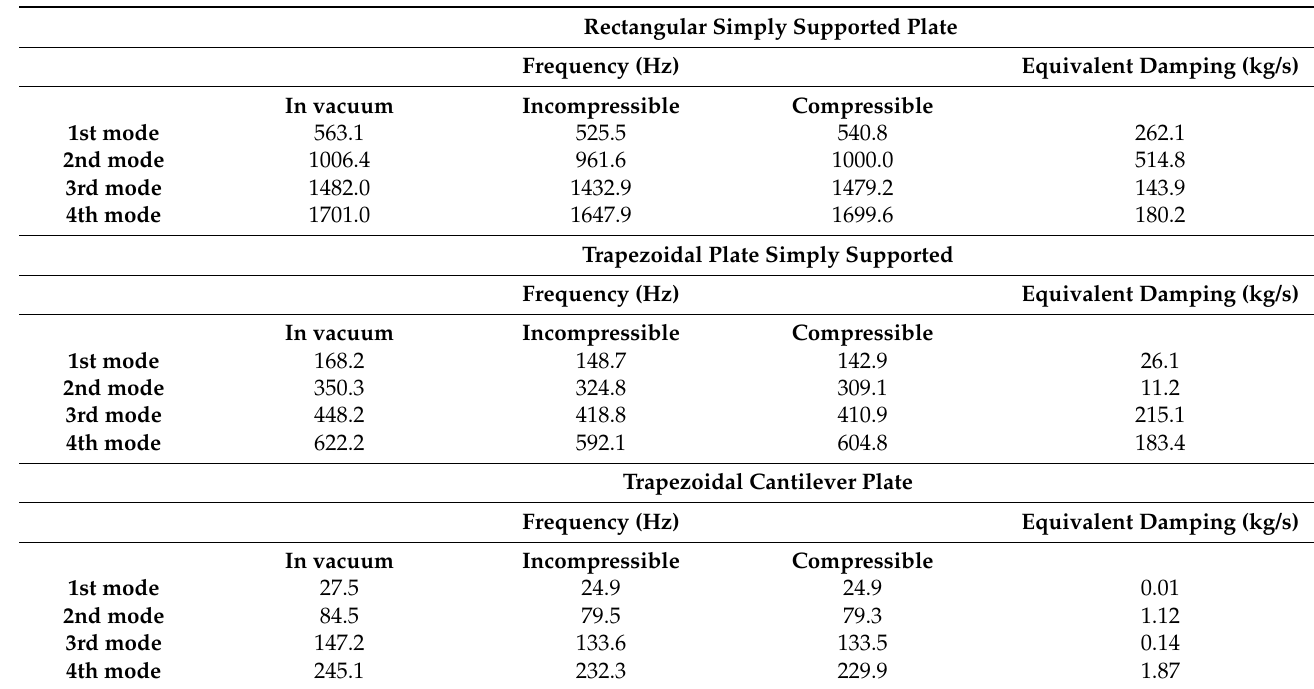
Table 1. Natural frequency and equivalent damping values for rectangular and trapezoidal